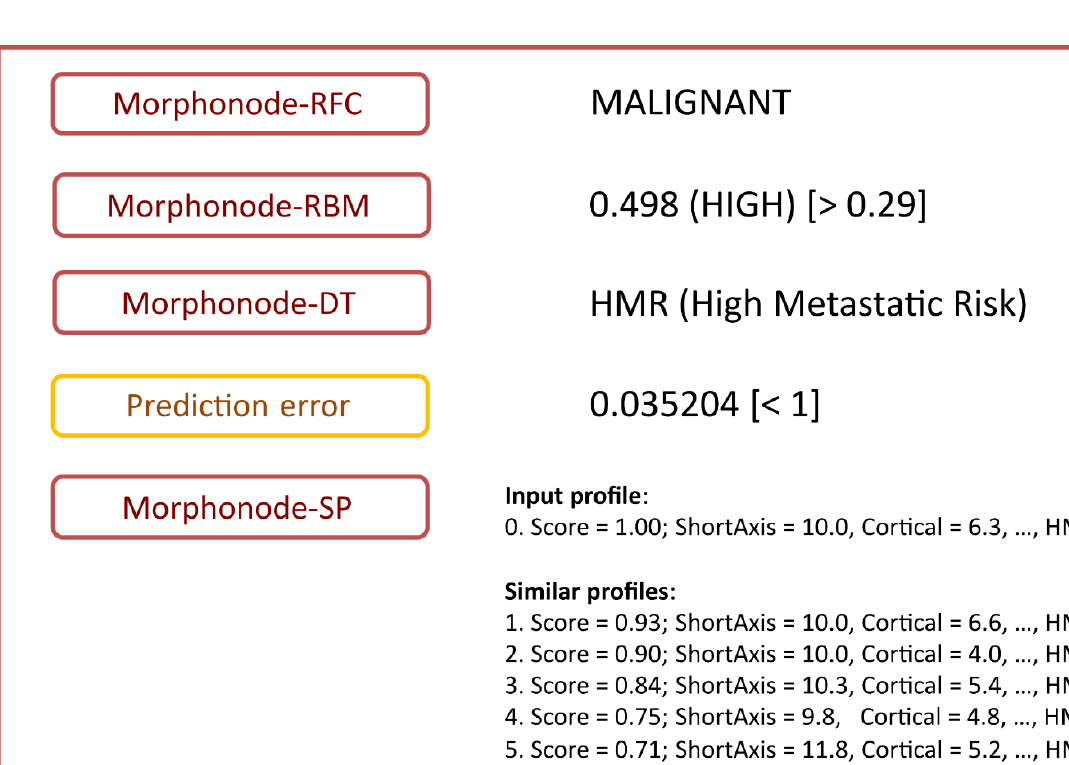
Figure 6. Morphonode Predictive Model output scheme.